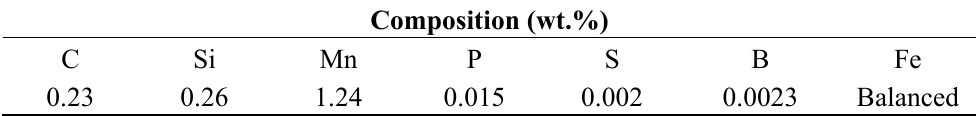
Table 1. Chemical composition of the SABC1470 steel used in the hot stamping